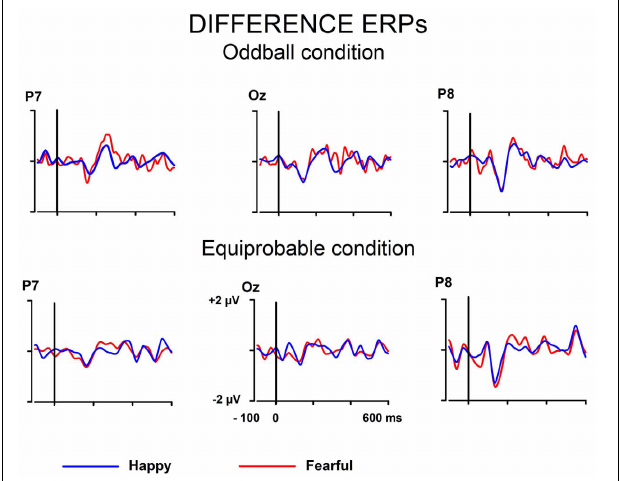
FIGURE 3 | Grand-averaged differential ERPs (emotional minus neutral face). Raw